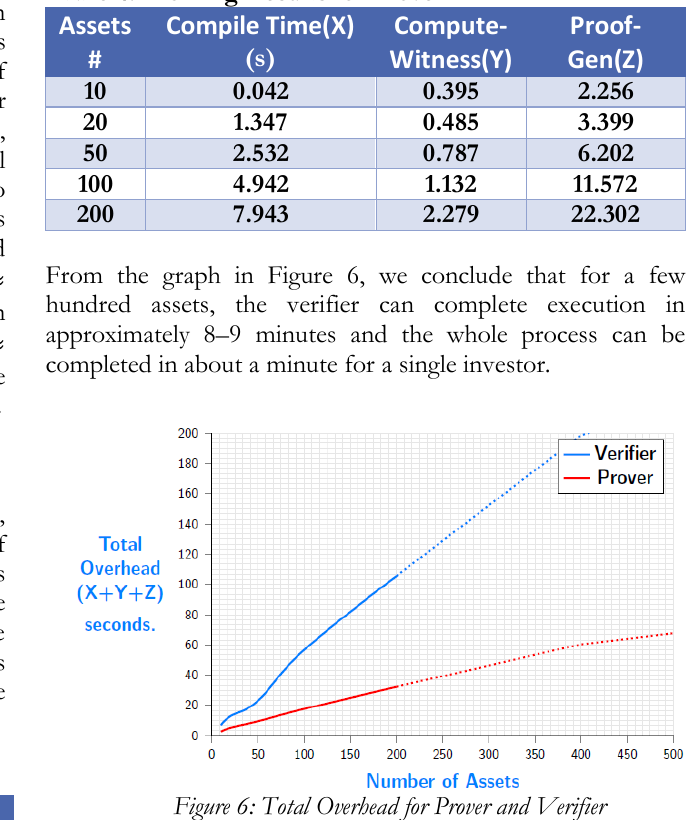
Figure 6: Total Overhead for Prover and